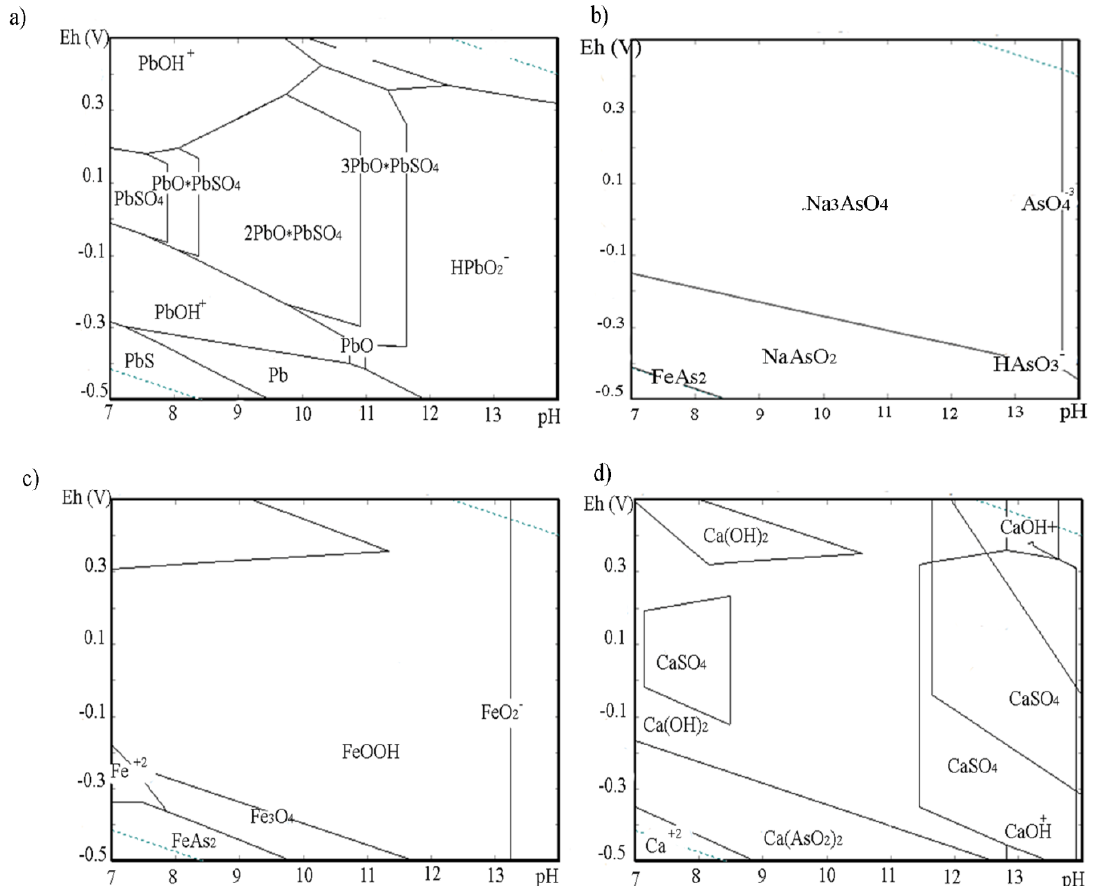
Figure 2. Eh-pH diagrams of ( a ) Pb, ( b ) As, ( c ) Fe, and ( d ) Ca species in the system As-Pb-S-Fe-Na-H 2 O